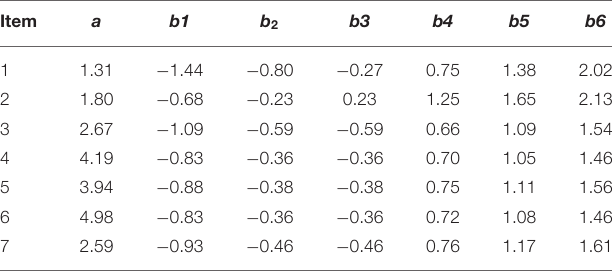
TABLE 7 | Estimated parameters of the graded response model applied to the